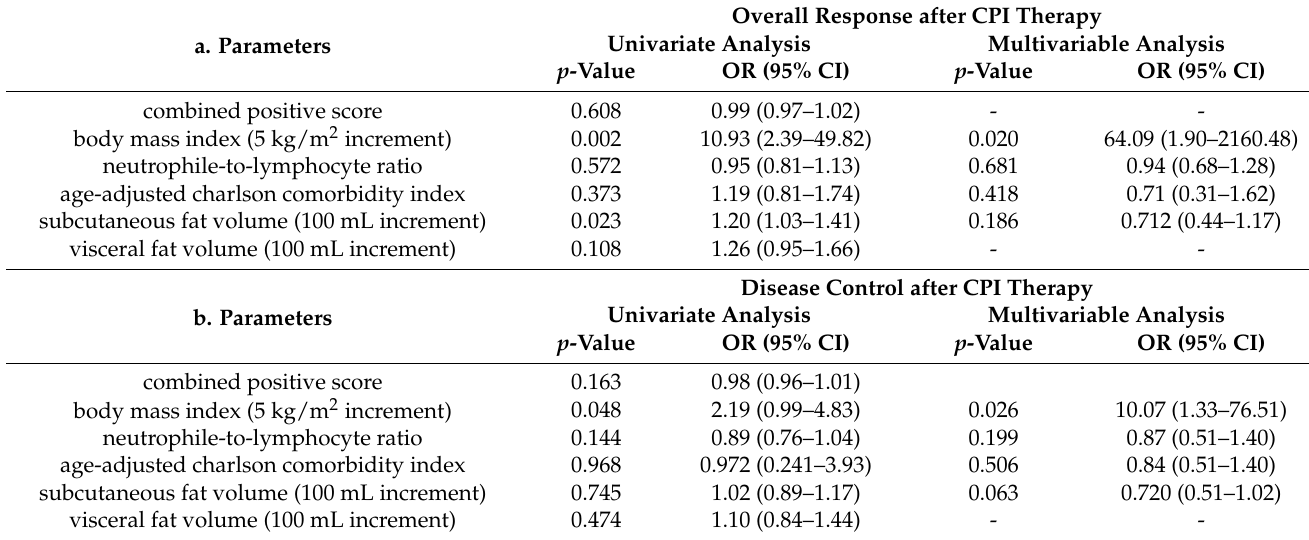
Table 2. Univariate and multivariate analysis to assess parameters predictive for overall response ( a ) and disease control ( b ) at the timepoint of pembrolizumab therapy initiation.